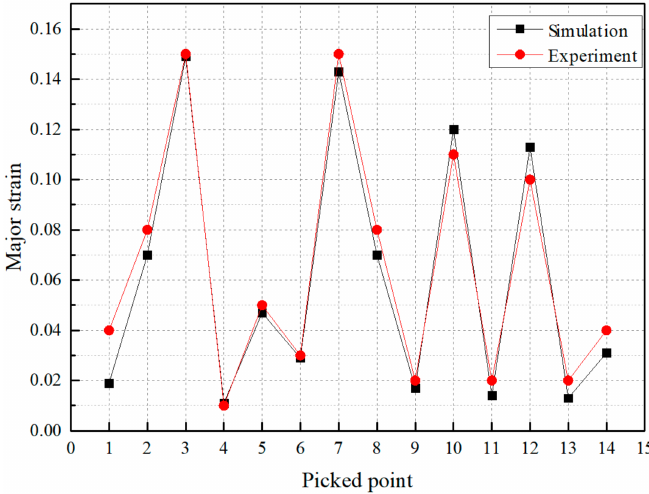
Figure 17. Major strain values at the picked points in Figure 15.